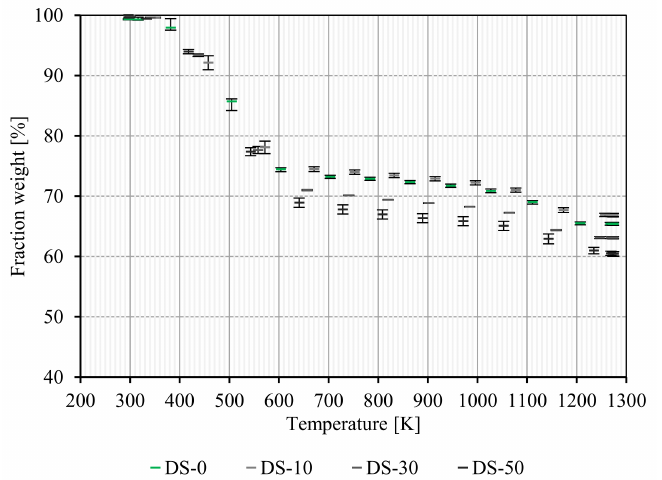
Figure 4. Mass changes of the brick mixtures when heated with a heat rate of 20 K min − 1 (from ambient temperature) to 1273 K, in air